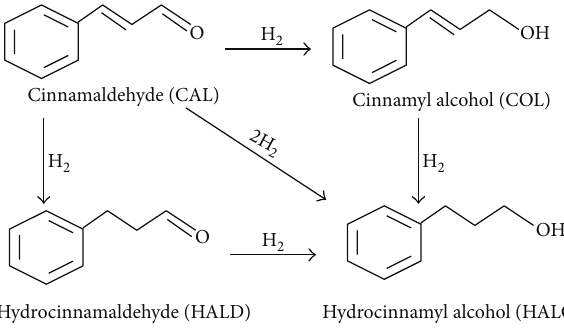
Scheme 1: Reaction pathways for cinnamaldehyde